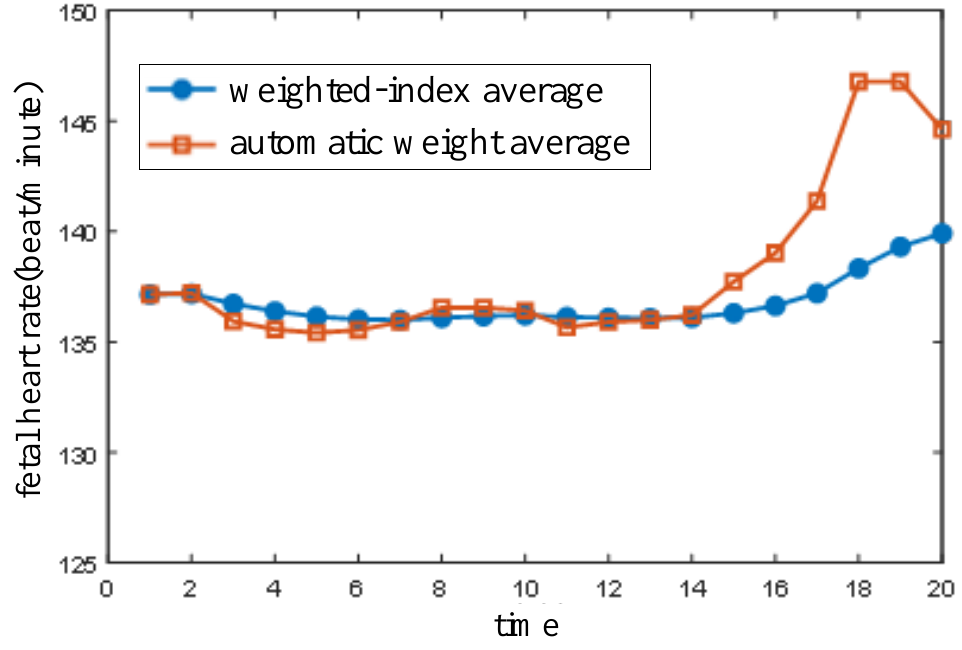
Figure 8. Weighted-index average algorithm. The fetal heart rate was corrected by the weighted-index average algorithm on the basis of extraction using the automatic weight algorithm. The subtle fluctuation was eliminated from the second calculation to the twelfth and the fetal heart rate tended to rise from the fourteenth to the twentieth. The jumping fetal heart rate was weakened by the weighted-index average algorithm and the variation in the fetal heart rate became more stable. The expected effect was realized and the results were consistent with